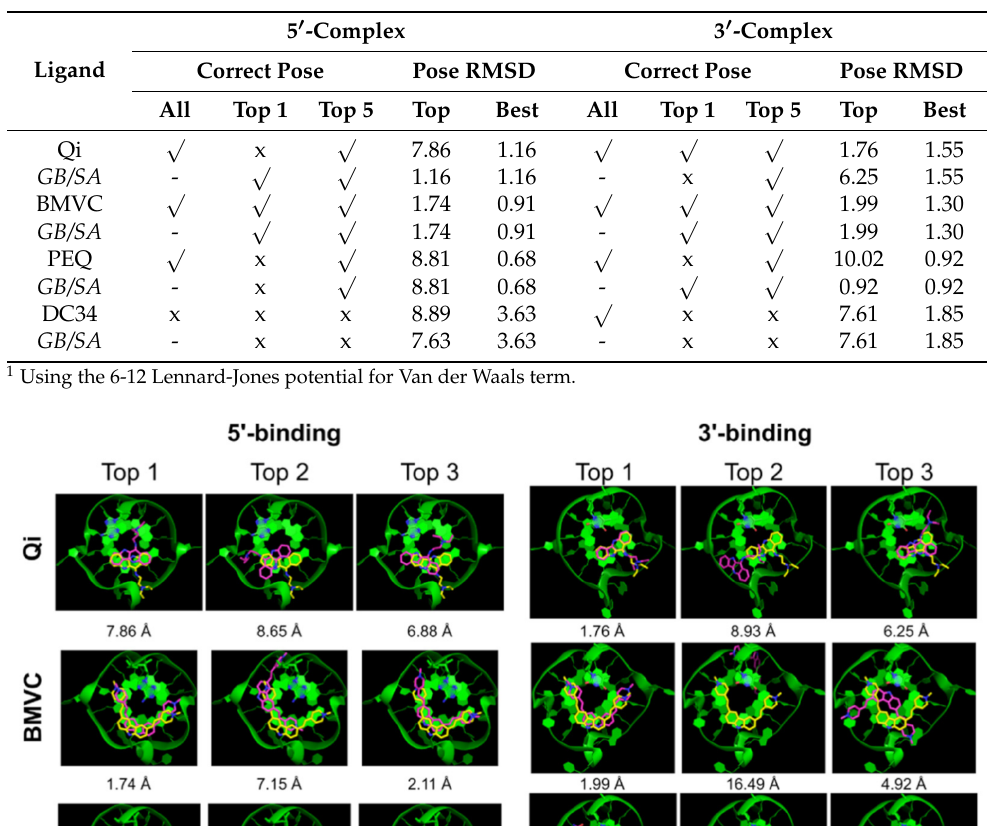
Table 2. Results obtained using DOCK 6 1 .